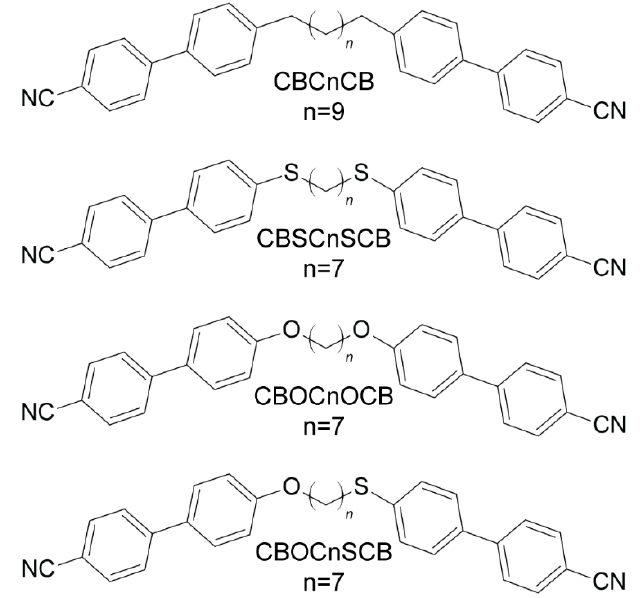
Figure 5. Chemical structures of the investigated